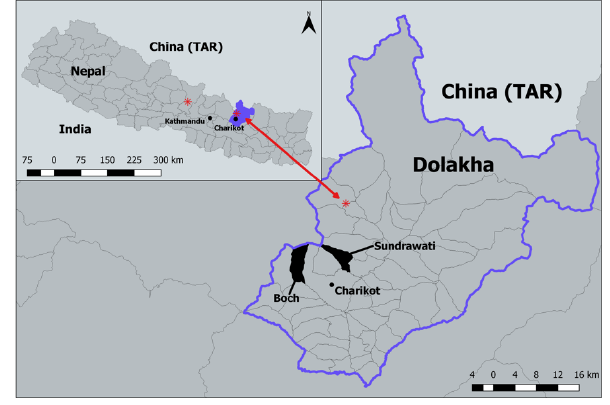
Fig. 1 . Map of study sites in the Dolakha District of Nepal. Epicenters of the two massive earthquakes 25 April, magnitude 7.8 NW of Kathmandu in Gorkha District and 12 May, magnitude 7.3 NE of Kathmandu in Dolakha District are denoted by